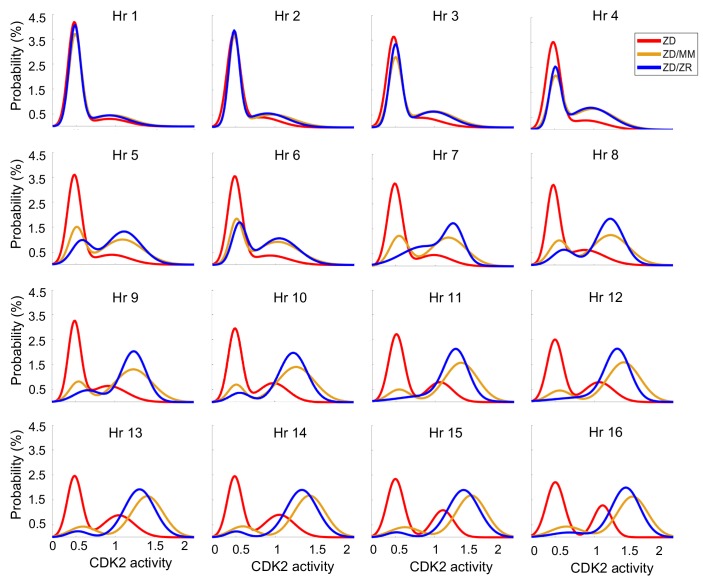
Zn2+ resupply allows for re-entry into the cell cycle following Zn2+ deficiency-induced quiescence.CDK2 activity density plots after cells either remain in ZD medium or are resupplied with MM or ZR. Hr indicates number of hours after resupply, for example Hr 1 = 1 hr after resupply, or hour 25 of the experiment (n = 210, 207, 202, 195, 196, 196, 191, 187, 185, 188, 188, 187, 187, 181, 178, and 176, for Hr 1–16 for ZD pooled from four wells, 1068, 1121, 1129, 1124, 1127, 1142, 1149, 1154, 1165, 1169, 1170, 1178, 1191, 1187, 1182, and 1198, for MM pooled from eight wells, and 1024, 1067, 1085, 1103, 1120, 1124, 1137, 1139, 1144, 1150, 1148, 1153, 1156, 1157, 1166, and 1162 for ZR pooled from four wells for ZD and eight wells for ZD/MM and ZD/ZR).